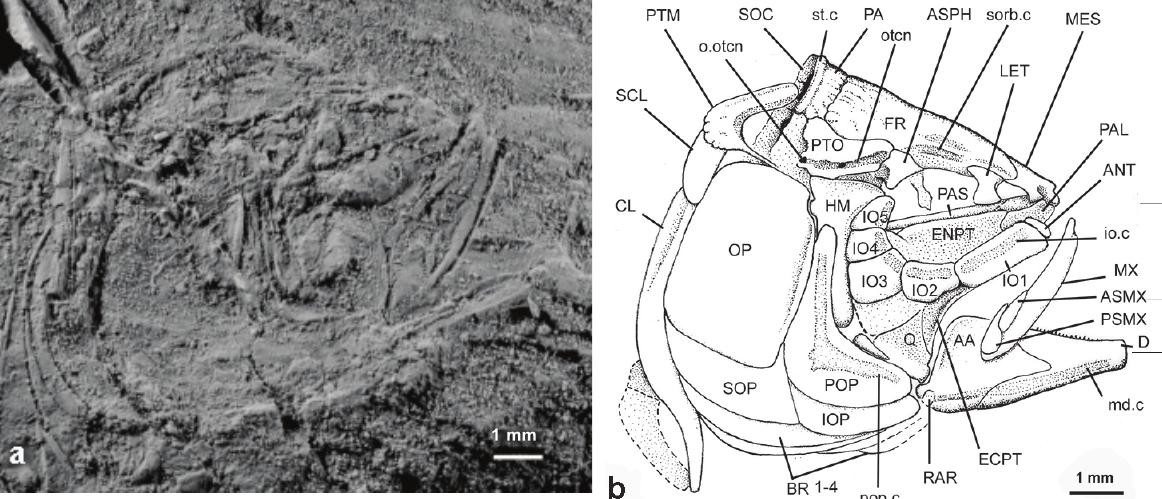
Figura 4. † Scutatuspinosus itapagipensis Santos and Corrêa 1985: (a) photograph of DGM 1253-P; (b) interpretative line-drawing of skull and pectoral girdle of DGM